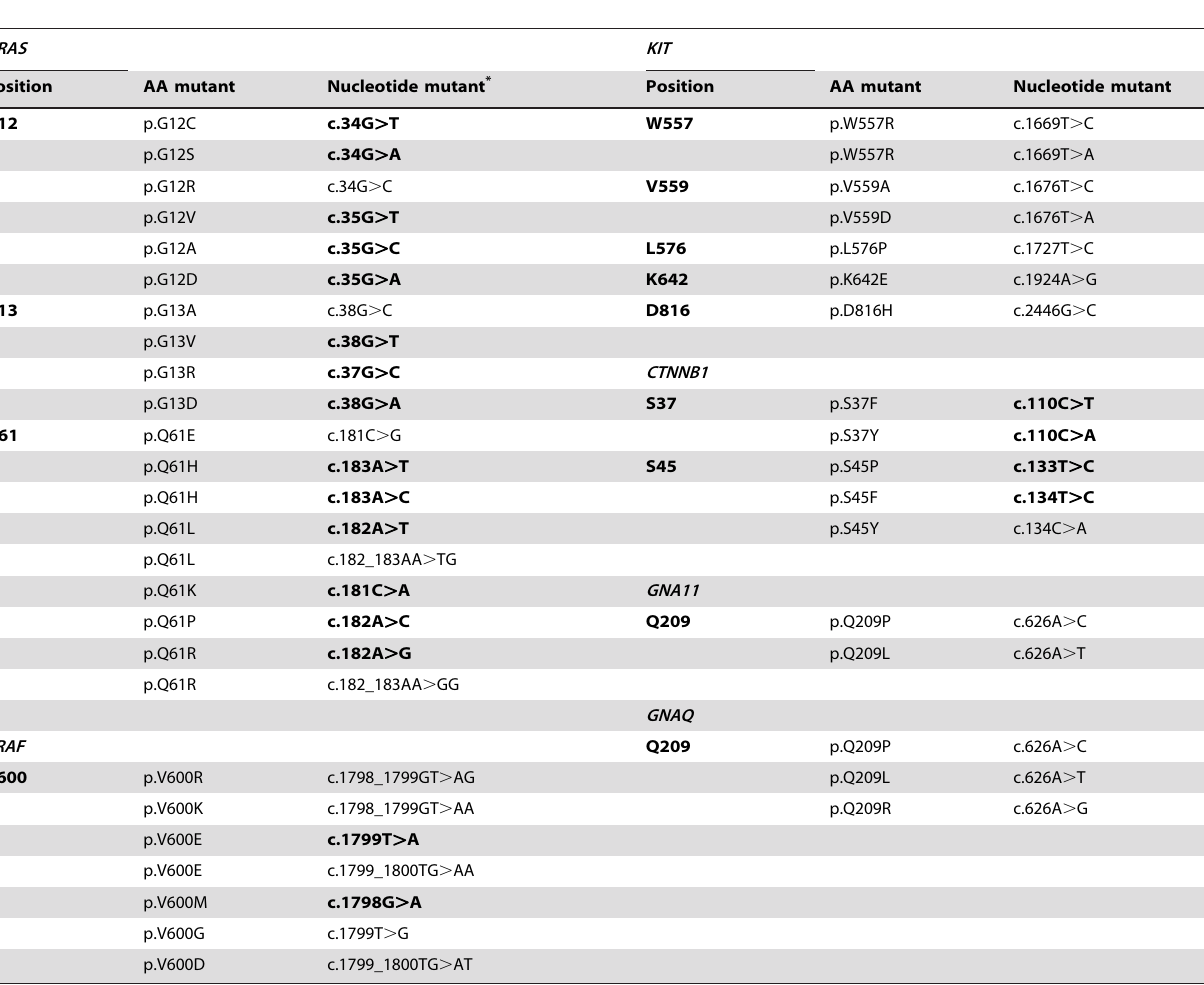
Table 2. The SNaPshot melanoma screen can detect 43 point mutations in 6 genes relevant to targeted therapy in melanoma.